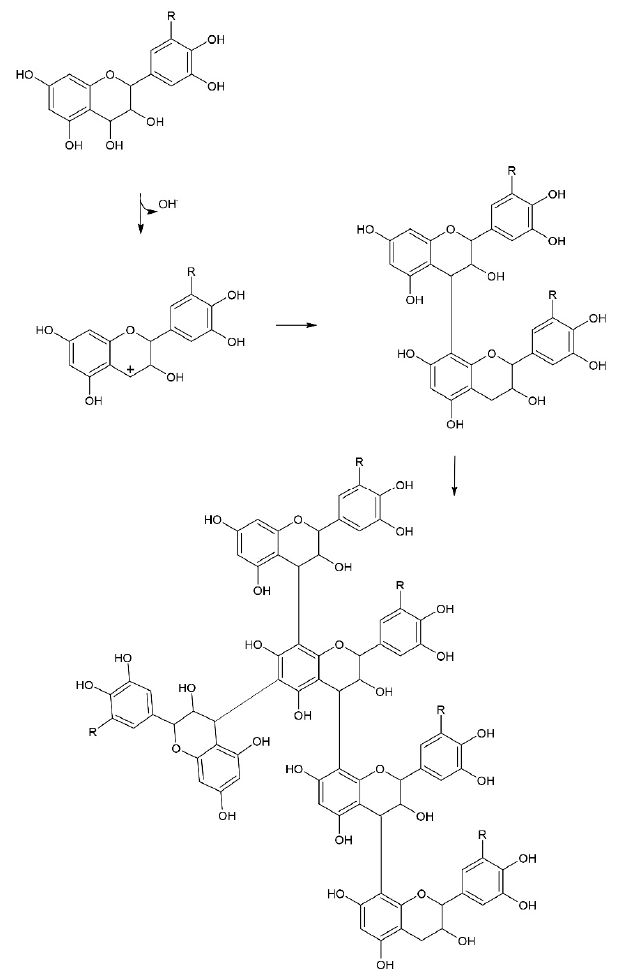
Figure 2. Condensation of polyphenols.